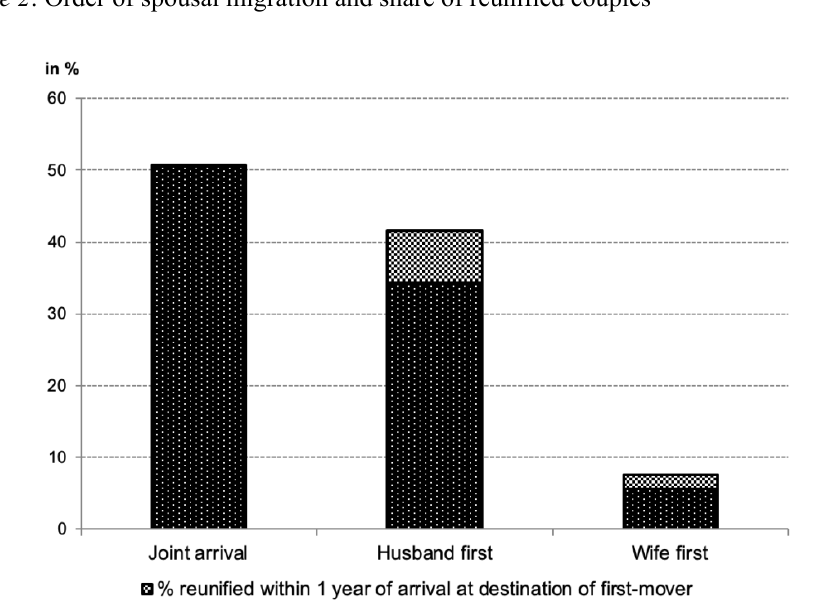
Figure 2 : Order of spousal migration and share of reunified